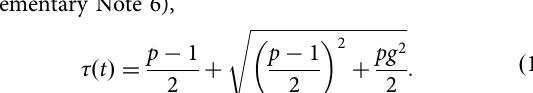
Fig. 2 Gaussian approximated positive- P (GAPP) model and comparison with photon number state expansion of effective density matrix (EDM) equation and with Gaussian approximated truncated Wigner (GATW) model. a Time-dependent parametric excitation ( p ). Broken line shows the threshold for solitary degenerate optical parametric oscillator (DOPO). b , c Time development of mean amplitudes ( μ 1 , μ 2 ) and variances ( h Δ ^ X 2 anti-ferromagnetically coupled 2-spin GAPP model. Inset shows the minima of effective potential that two DOPOs have chosen. d t = 4 success probability of 2-spin antiferromagnetically coupled DOPOs. e t = 4 mean success probability of 3-spin system with randomly generated ~ J rr 0 . In d , e , blue lines show the results of GAPP without measurement-induced state reduction ffiffiffiffiffiffiffiffiffiffiffiffiffiffiffiffiffiffiffiffiffiffiffiffiffiffiffiffiffiffiffiffi